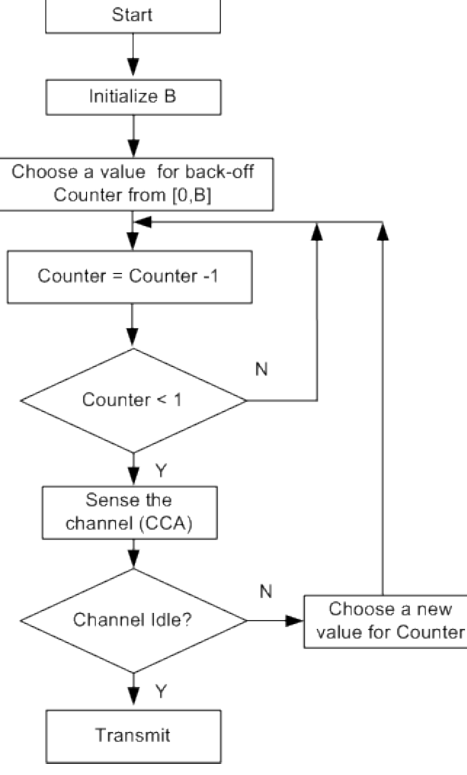
Figure 14. Back-off